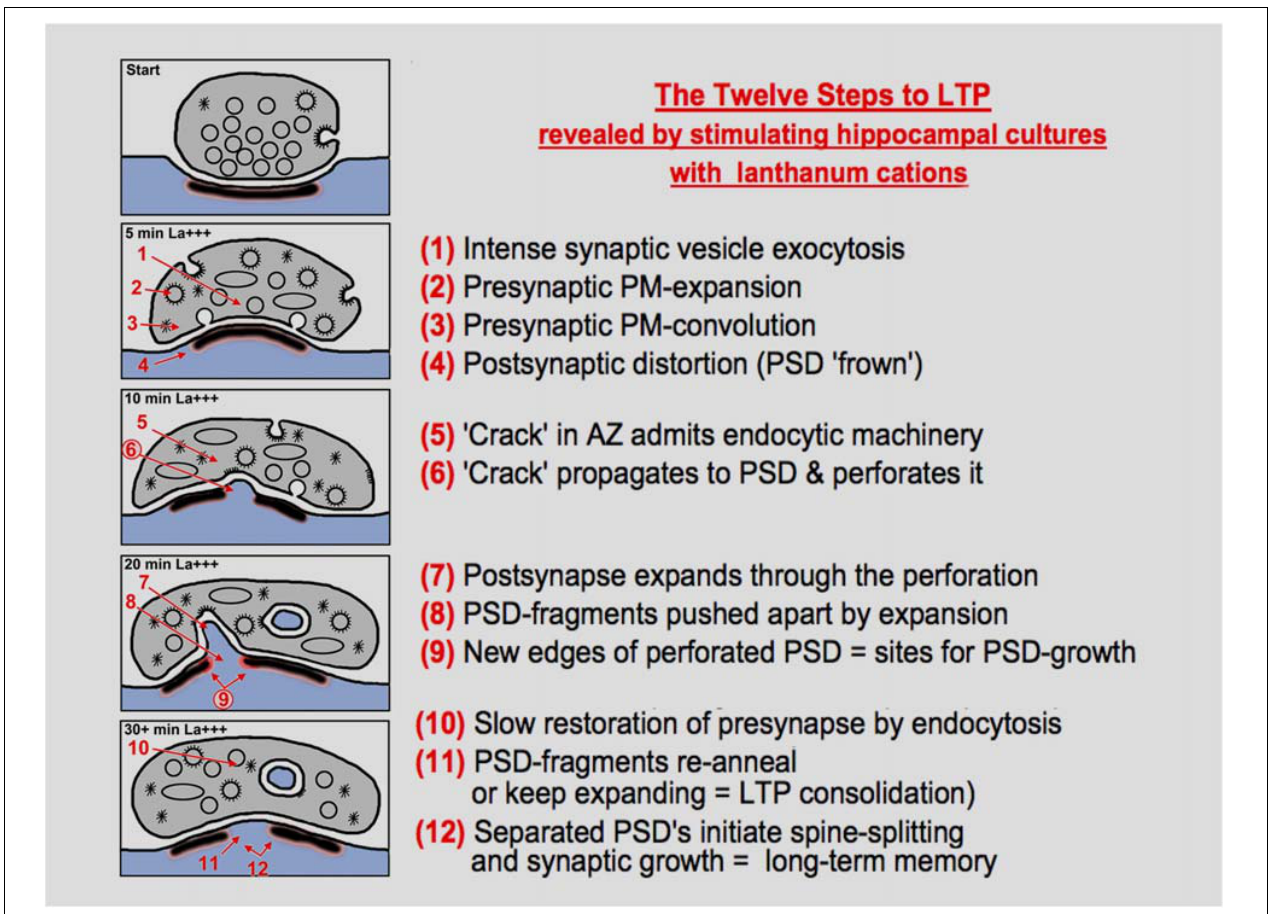
FIGURE 7 | Diagrammatic summary of the observations, interpretations, and hypotheses presented in this study, presented as “twelve steps”, to paraphrase a term from popular culture. The diagram is self-explanatory, but many steps will need to be validated or explained mechanistically by future work, especially the idea that enhanced endocytosis can cause a “break” in the presynaptic active zone (AZ), and that this break can propagate to the PSD to begin the process of perforation or intrusion or spinule formation.